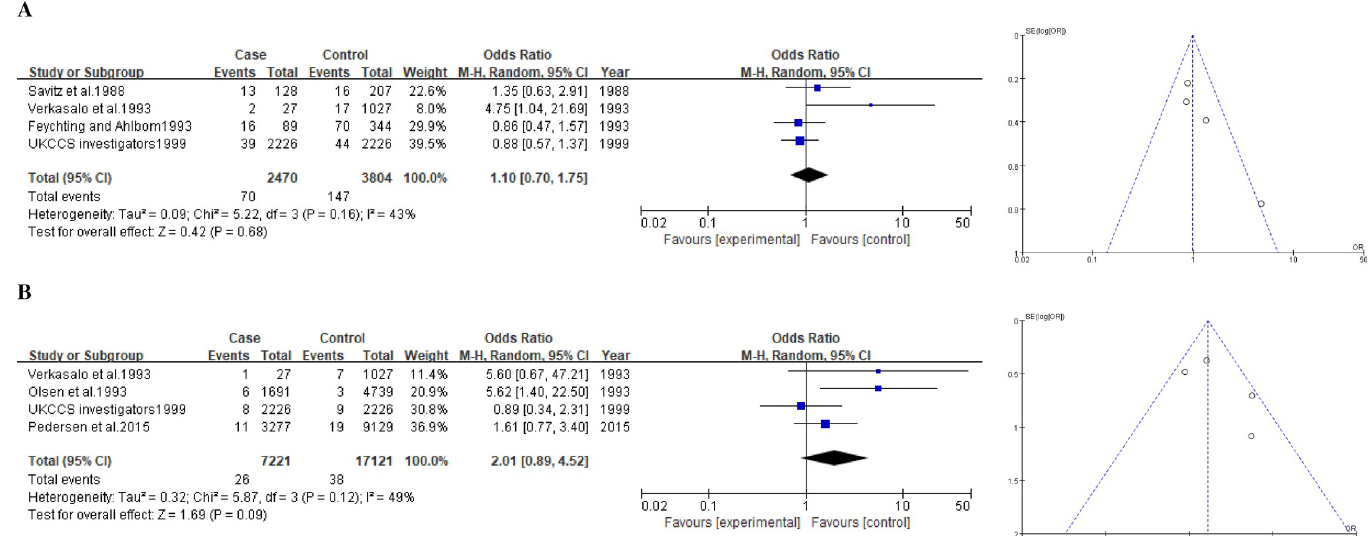
Fig 4. Forest plot and funnel plot of exposure to ELF-MFs and risk of any childhood cancer. The pooled odds ratio of any childhood cancer by each exposure level of ELF-MFs: A 0.2- μ T exposure level; B 0.4- μ T exposure level.